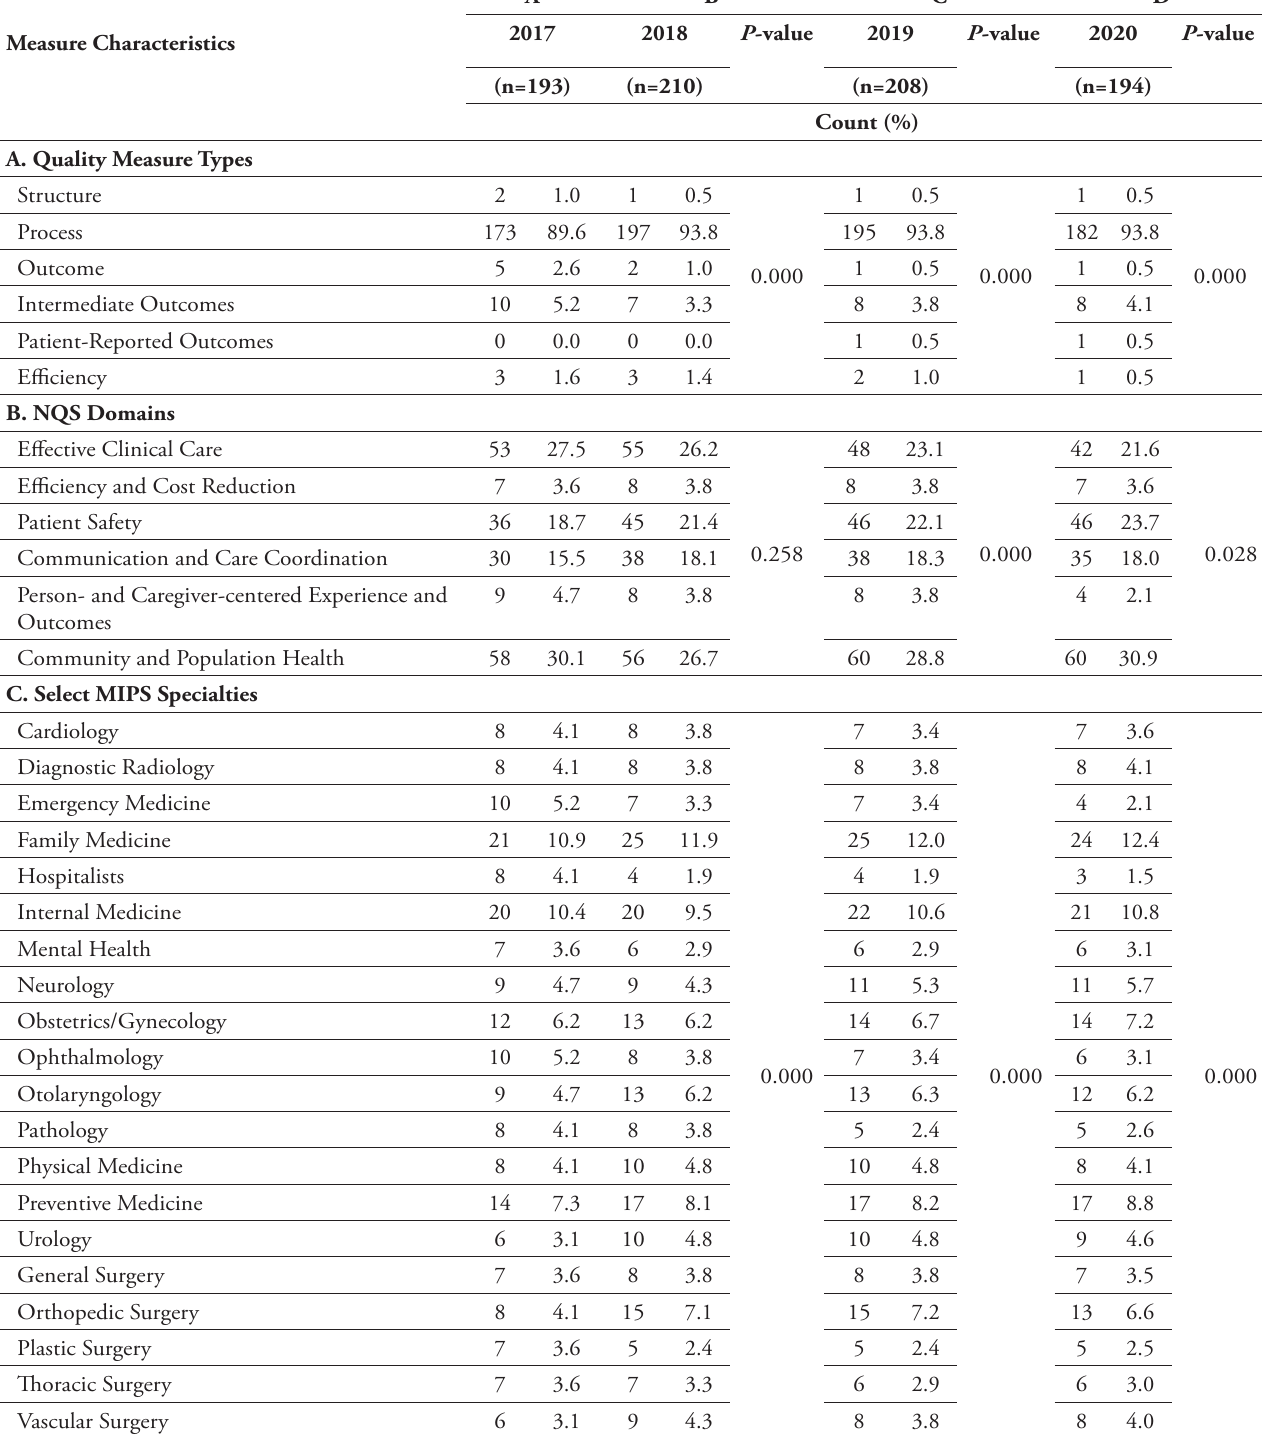
Table 4. MIPS Measure Characteristics Analyzed by Pearson’s Chi-Square Test (Years 2017 through 2020)